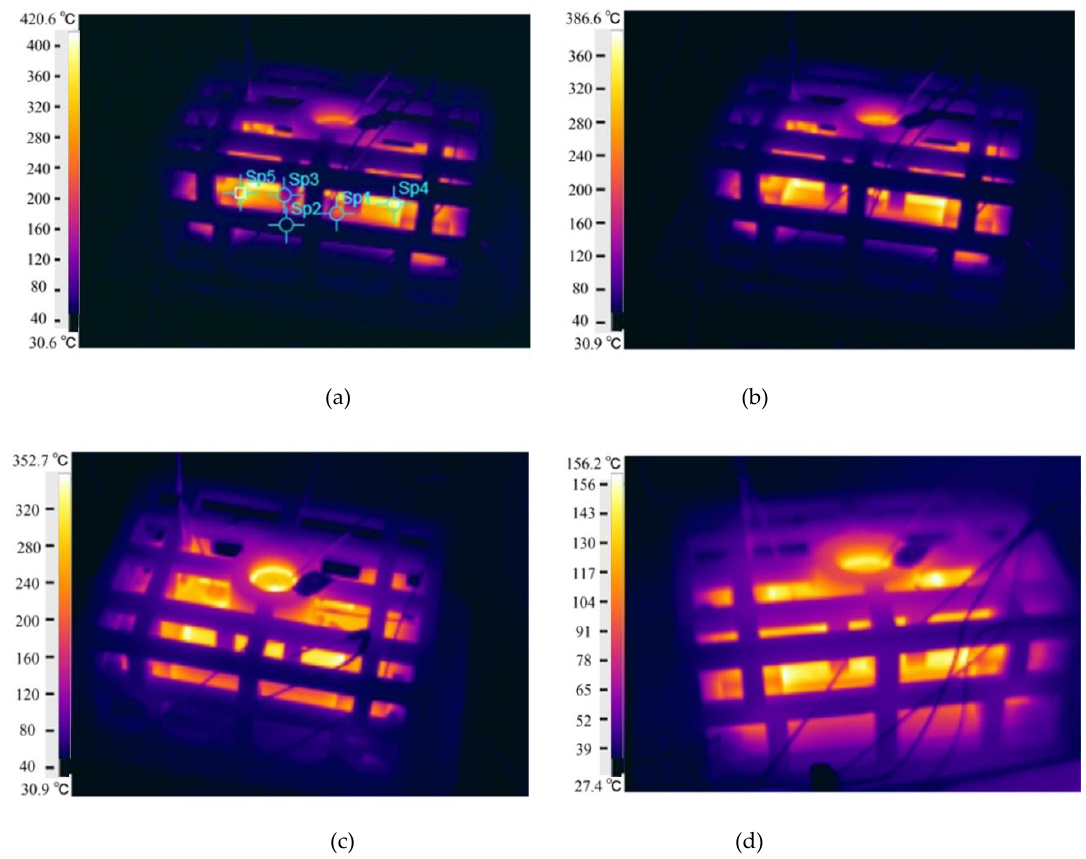
Figure 30. Infrared imaging of the skeletal sand mold surface temperature: ( a ) 250 s; ( b ) 300 s; ( c ) 700 s and ( d ) 2000 s.